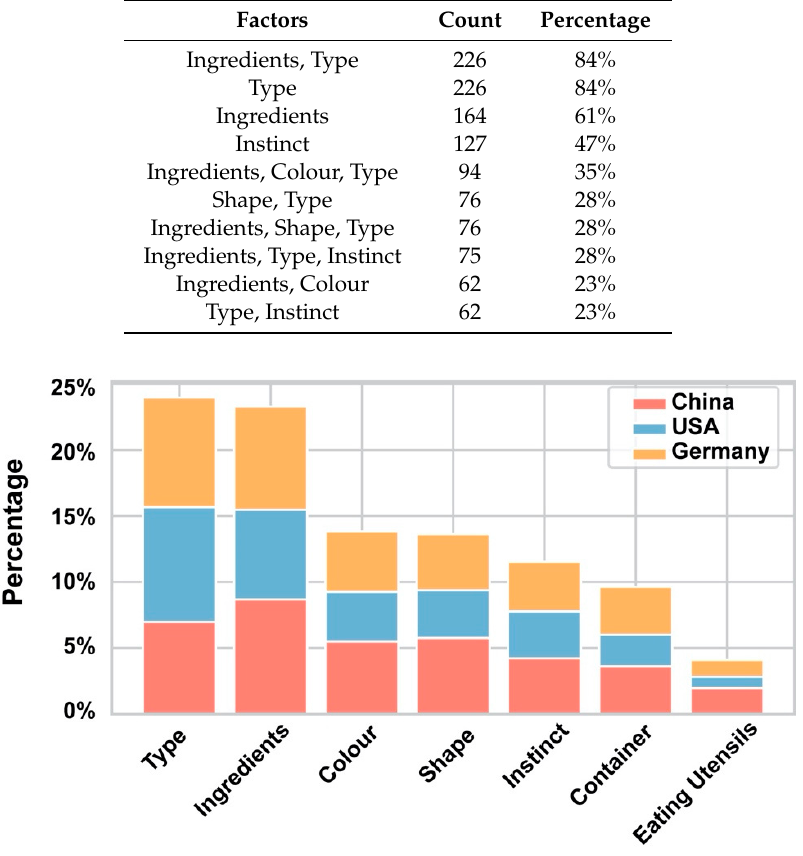
Table 5. Coding scheme for factors reported by participants. Categories